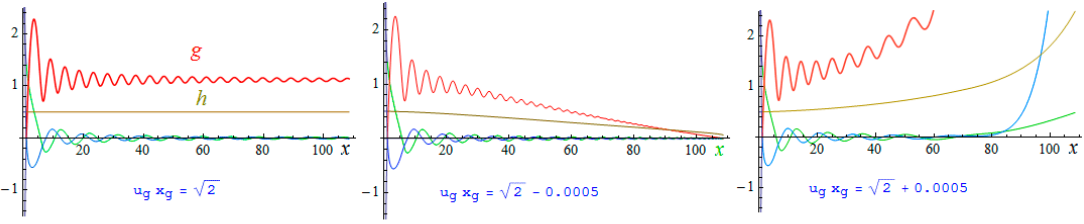
Figure 4. Functions u ( x ) green, w ( x ) blue, g( x ) red, and h ( x ) brown in the vicinity of the upper border of the strip in Equation (36).